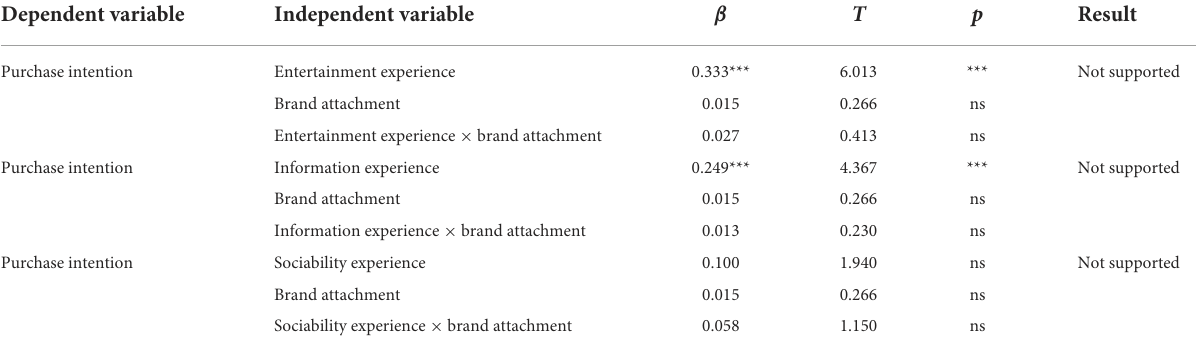
TABLE 5 Analysis of moderating